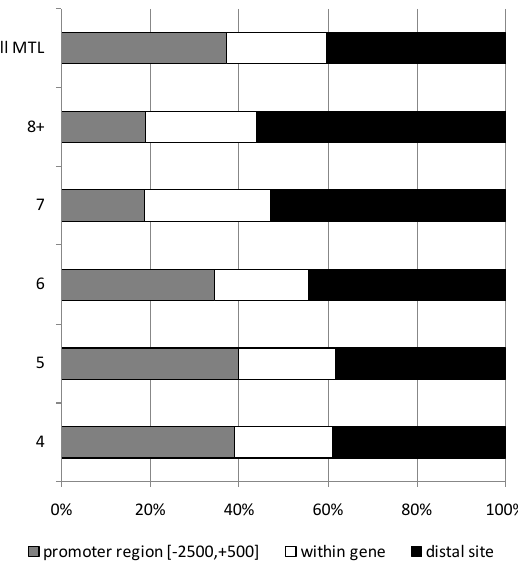
Figure 4: Distribution of TFBS in multiple regulatory loci relative to RefSeq genes depending on number of sites in the cluster.